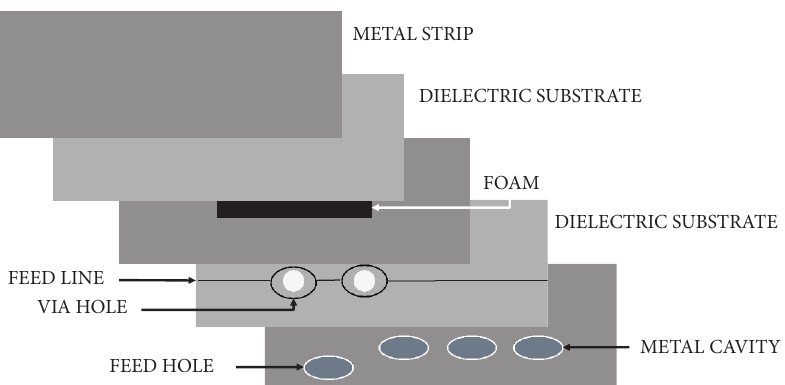
Figure 5: Capacitive loaded cavity backed RFID slot antenna structure.